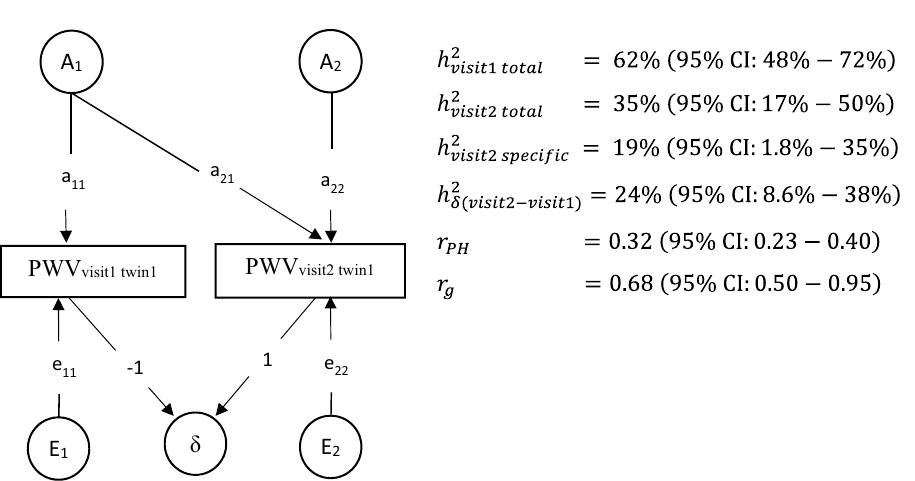
Figure 2. Path diagram for best fitting bivariate structural equation model (Cholesky model). The best fitting model was model composited of additive genetic factor (A), unique environment factor (E). The path of genetic factors between two visits is a 21 . The path of unique environmental factors between the phenotypes of the two visits is e 21 . The pathway a 21 and a 22 cannot be set to 0 while pathway e 21 can be set to 0. r PH is the phenotypic correlation for PWV between visit 1 and visit 2. r g is the genetic correlation for PWV between visit 1 and visit 2. r g = COV A (1st visit, 2nd visit)/√ (V A 1st visit * V A 2nd visit), with COV A represents covariance and V A represents